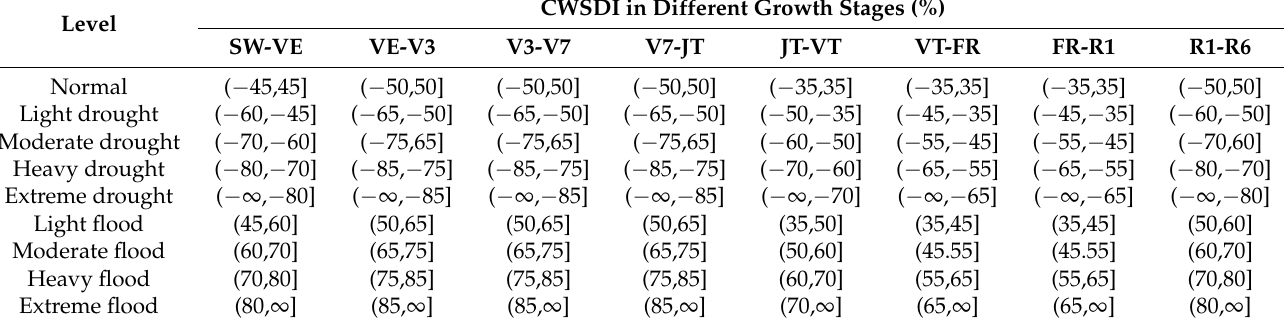
Table 3. Range of CWSDI in each growth